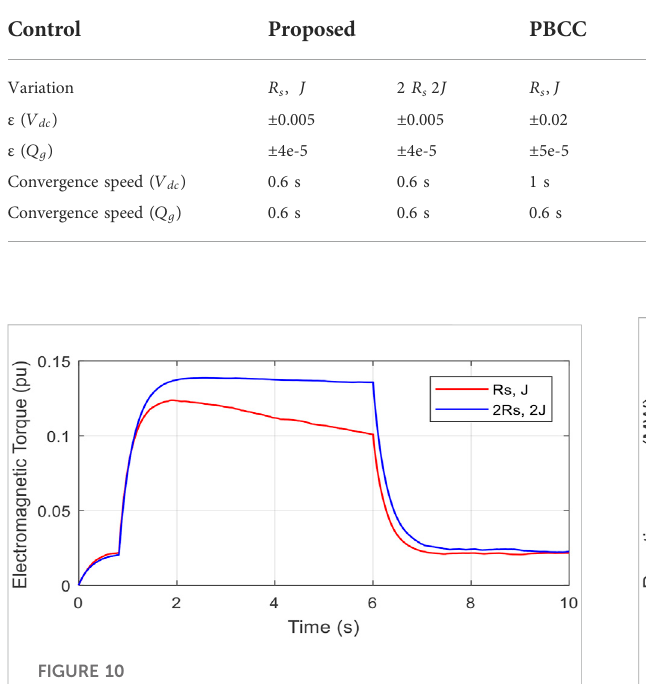
FIGURE 10 Zoom on convergence speed of the reactive power.